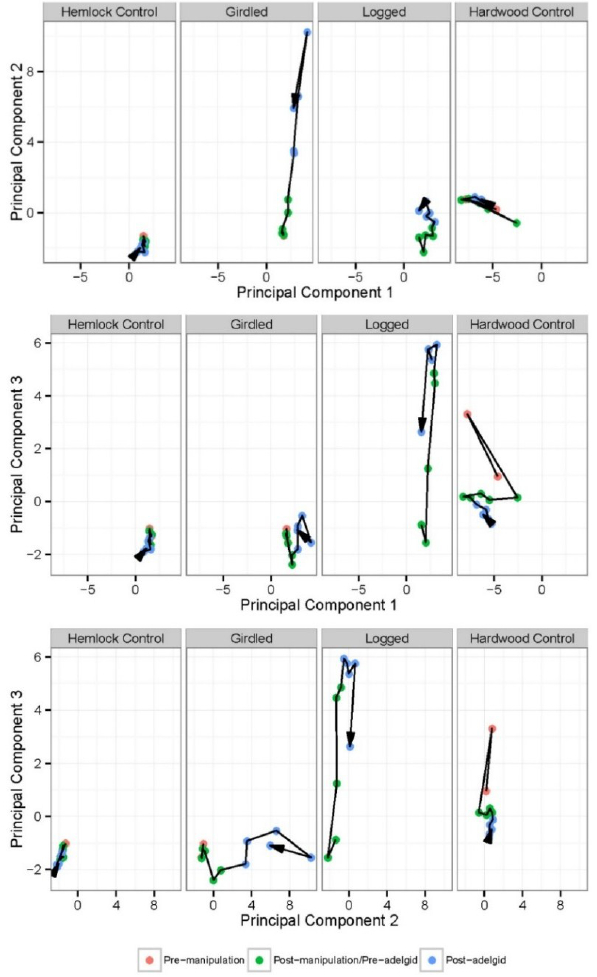
Figure 2. Temporal trajectories of understory vegetation composition in principal components space in the Harvard Forest Hemlock Removal Experiment. Each point represents the vegetation composition in a given year, and the line traces the trajectory through time from before canopy manipulations (2003–2004: red points), after manipulations but prior to adelgid colonization of the plots (2005–2009: green points), and after the adelgid had colonized the plots (2010–2014: blue points). In four of the panels (PC1 vs. PC2 for the girdled plots, and all three panels for the logged plots), the 2003–2004 vegetation composition was not distinguishable from the 2005 data and so the red symbols are not visible.